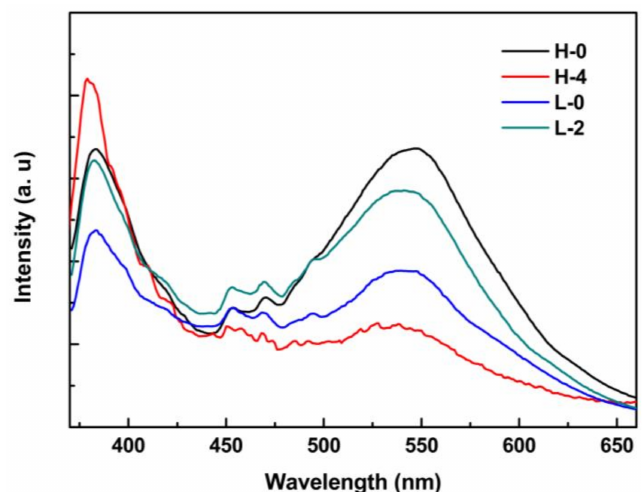
Figure 6. Room-temperature PL spectra of the sample H-0, H-4, L-0, and